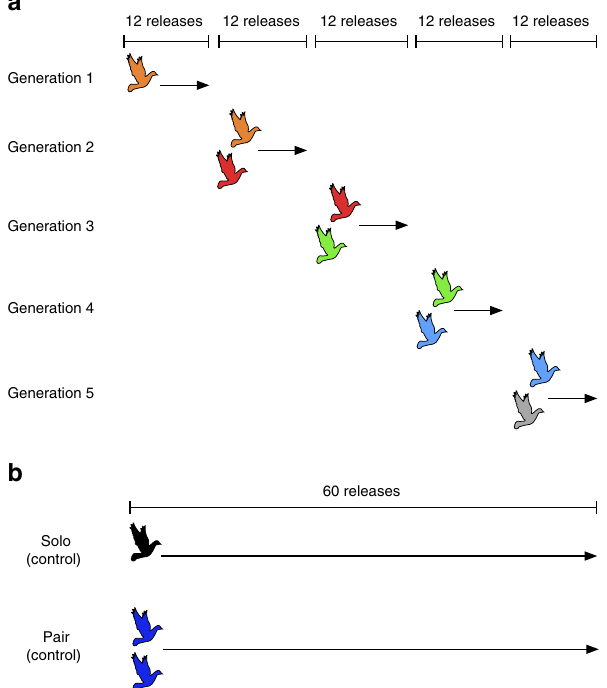
Figure 1 | Homing flight release protocols. ( a ) Experimental group; ( b ) control groups. In each chain of the experimental group, a single pigeon (orange) was first released from the same site repeatedly 12 times, then partnered with a naive pigeon (red) and flown as a pair a further 12 times. The first bird was then replaced by a third bird (green) and this new pair (red þ green) was also released 12 times. This procedure continued until the fifth-generation bird (grey) was added and flown a final 12 times. In the control groups ( b ), single pigeons and fixed pairs were released the same number of times as the total flown by the experimental group (60 flights). All three treatment groups contained 10 independent replicates (chains, solo birds or